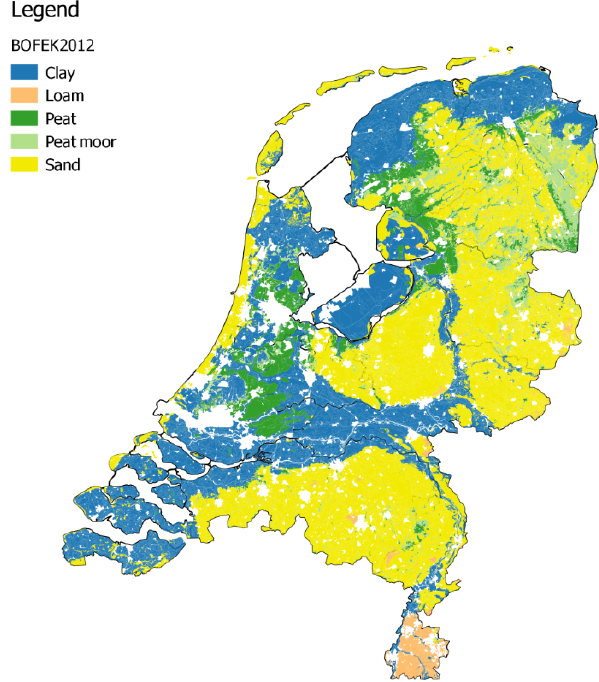
Physical Map of the Netherlands (Wösten et al.,